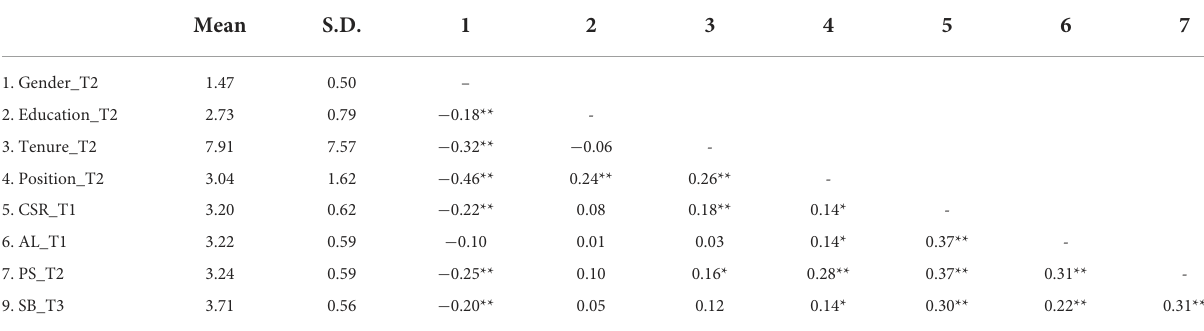
TABLE 2 Correlation between research variables. Mean